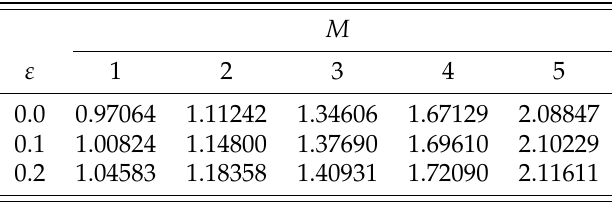
Table 2. Z (Heat transfer coefficient) as function of M and ε . Here x = 0.1, Q = − 1.2, β 1 = 0.2, β 2 = 0.2, ϕ = π /4, λ 1 = 1, Br =